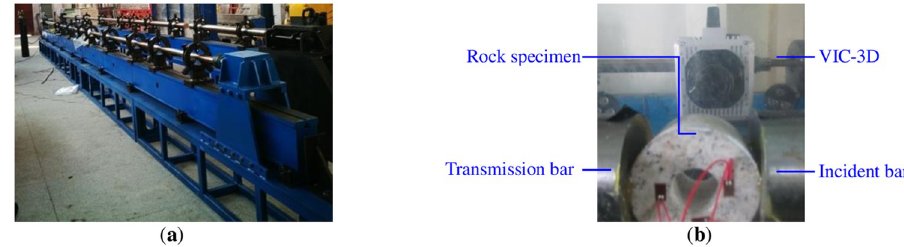
Fig 1. Mechanical test system with radial impact of circular granite specimens. ( a ) SHPB and ( b )